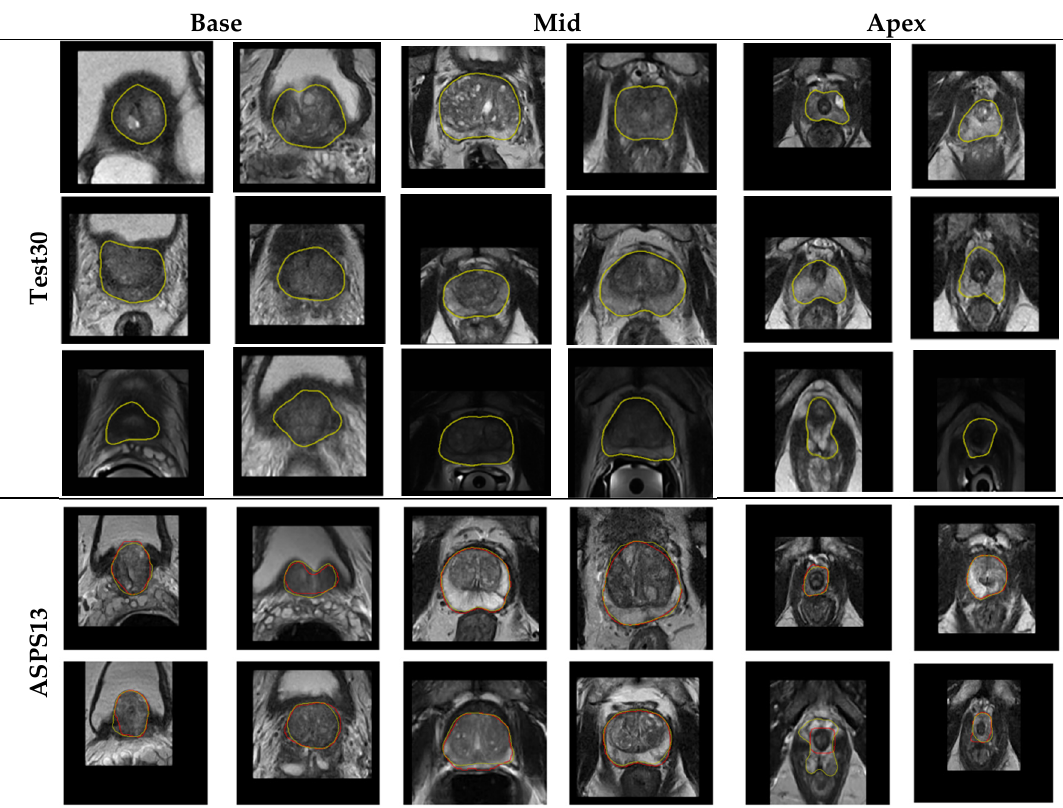
Figure 11. Test results of the algorithm on the Test30 and ASPS13.